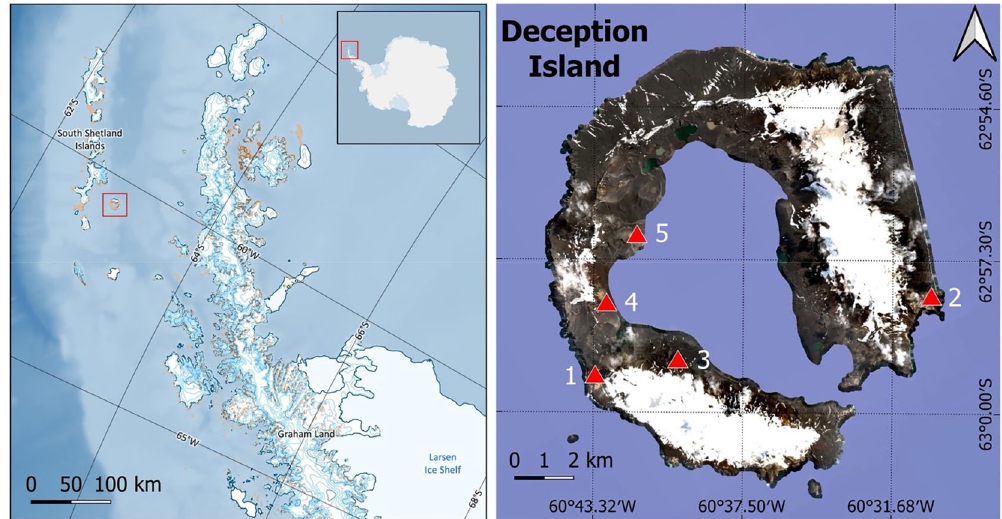
Figure 5. Location of Deception Island in the Antarctic peninsula and locations of UAV surveys carried out on Deception Island. 1: Vapour Col; 2: Baily Head; 3: Crater Lake; 4: Fumarole Bay; 5: Murature Formation. Data